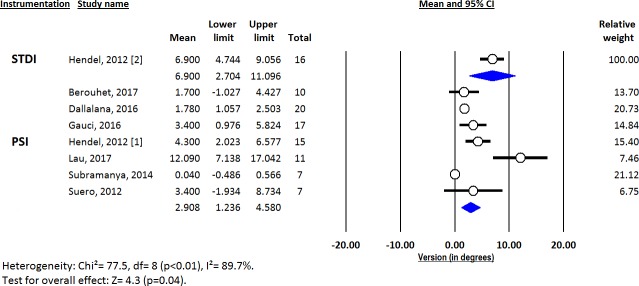
Forest plot of version deviation from the pre-operative planning, for clinical studies.